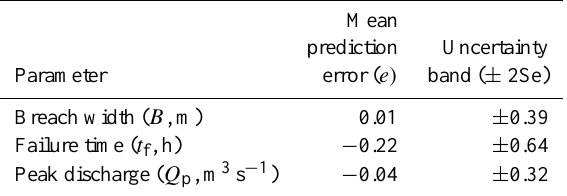
Table 2. Prediction error and uncertainty bands for the Froehlich breaching equations.